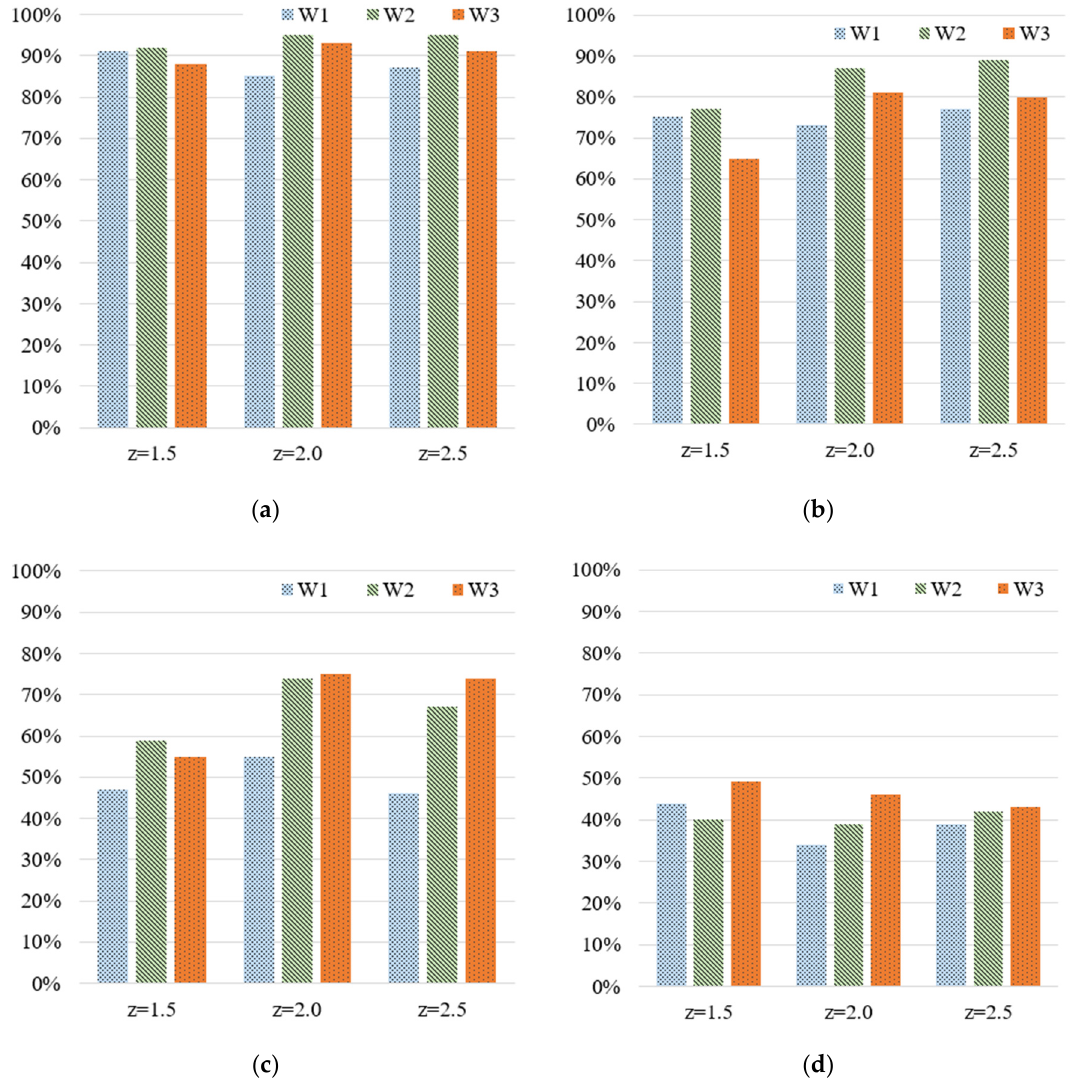
Figure 7. Testing accuracy for the widths of the IC tray with respect to various z-scores and numbers of grades: ( a ) 5, ( b ) 10, ( c ) 20, and ( d ) 50 grades. Table 7. Average testing accuracy versus z-score and number of grades.